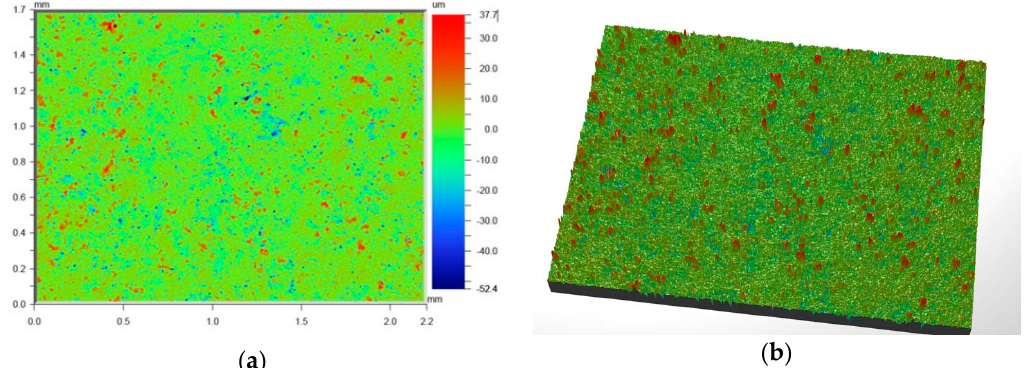
Figure 8. 2D ( a ) and 3D ( b ) profilographs of PW1 sample at a magnification of ×2.9.